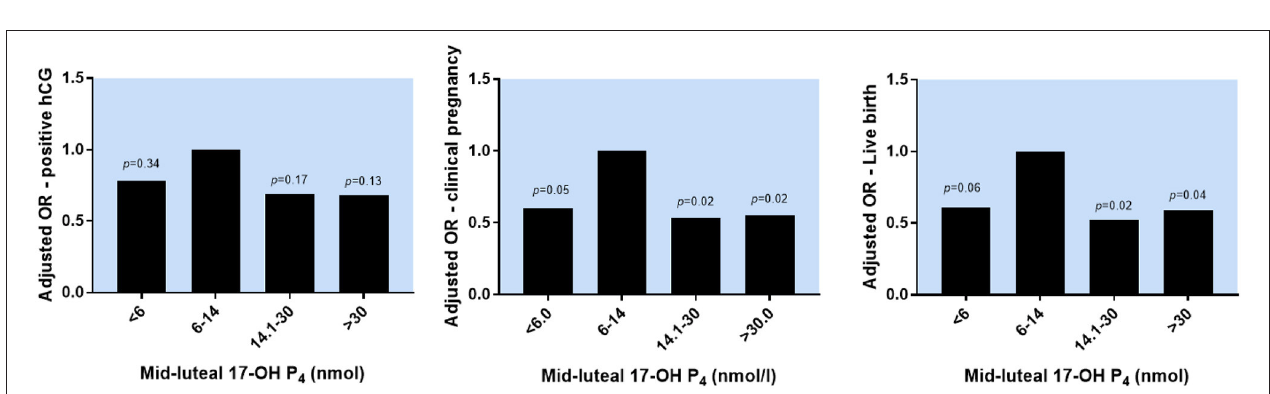
FIGURE 3 | The association between mid-luteal serum 17-OH P 4 levels and reproductive outcomes. OR for positive hCG, clinical pregnancy and live birth in different 17-OH P4 groups adjusted for maternal age, maternal BMI, day of embryo transfer, late follicular P4 levels, smoking and final number of follicles. P -values refer to the pairwise comparison between each 17-OH P4 category and the reference group (6–14 nmol/l).